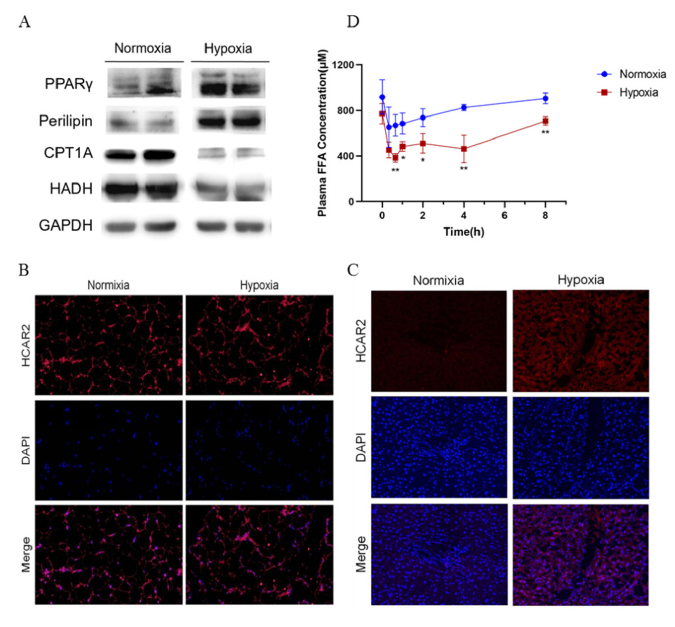
Figure 7. Effects of hypoxia on the expression of HCAR2 and lipid metabolism. ( A ) The expression changes of lipid metabolism-related proteins; ( B ) Immunofluorescence staining of HCAR2 in adi- pose tissue of normoxia or hypoxia rats; ( C ) Immunofluorescence staining of HCAR2 in liver of normoxia or hypoxia rats; ( D ) The changes of serum FFA in rats.